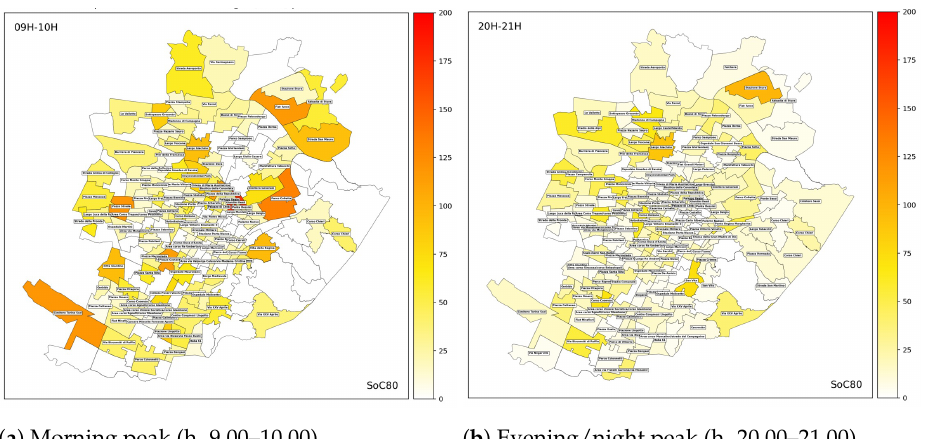
Figure 6. Distribution of power demand in the various areas of the city of Turin during daytime ( a ) and night-time ( b ) by